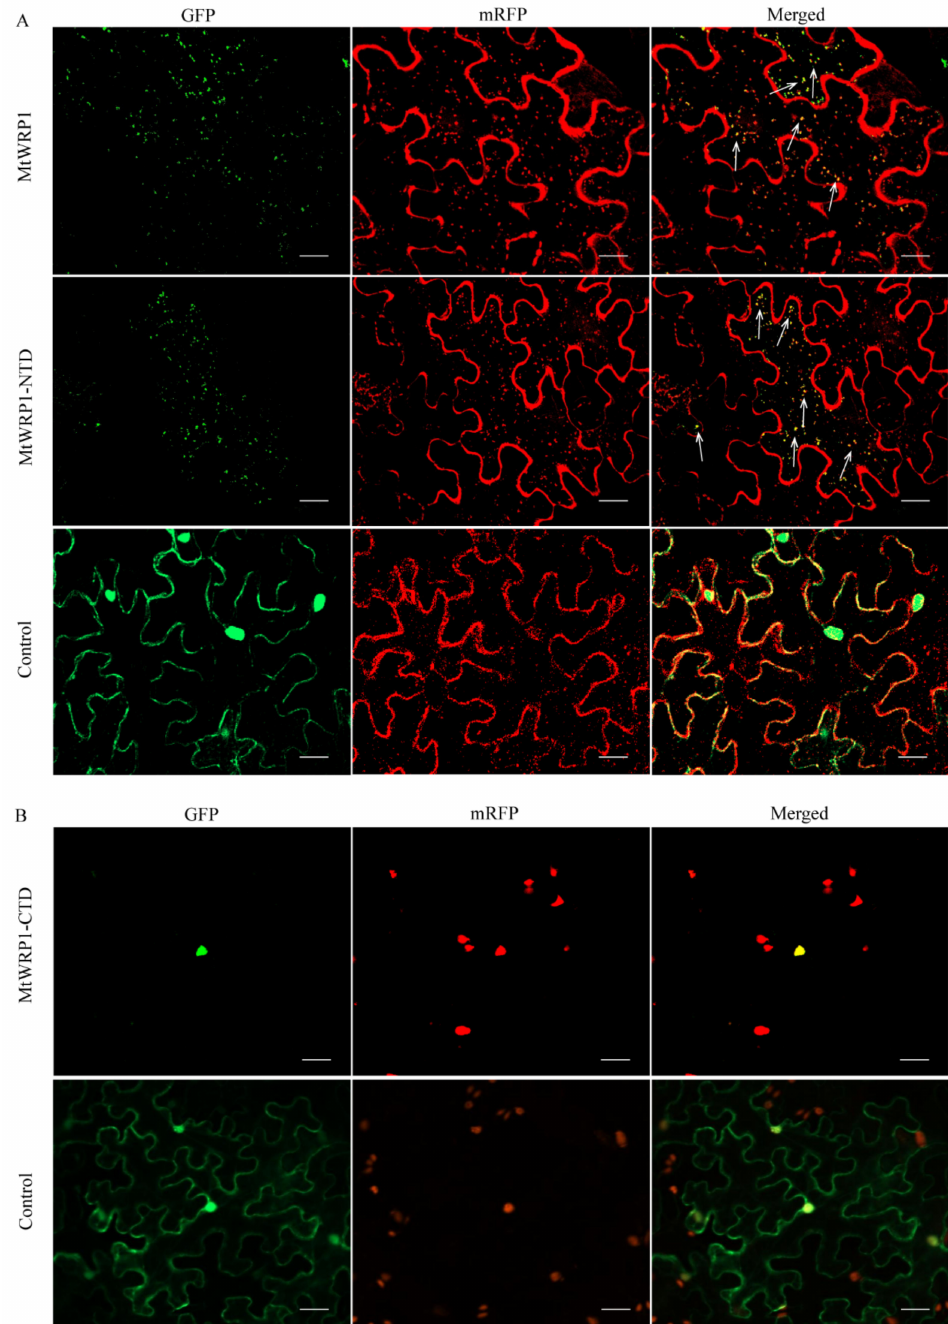
Figure 4. Subcellular localization: ( A ) Subcellular localization of MtWRP1 and TM domain at N-terminal of MtWRP1 (MtWRP1-NTD). A majority of MtWRP1-GFP and MtWRP1-NTD-GFP flu- orescence signals were overlapped with mRFP Golgi marker signals. The arrows indicated the localization of GFP-fused proteins overlapped with the mRFP Golgi marker signals. Co-localization of free GFPs driven by CaMV 35S and mRFP Golgi marker were used as control. ( B ) Subcellular localization of WRKY domain at C-terminal of MtWRP1 (MtWRP1-CTD). MtWRP1-CTD-GFP fluo- rescence signals were overlapped with mRFP nucleus marker signals. Co-localization of free GFPs and mRFP nucleus marker were used as control. Bar, 20 µ